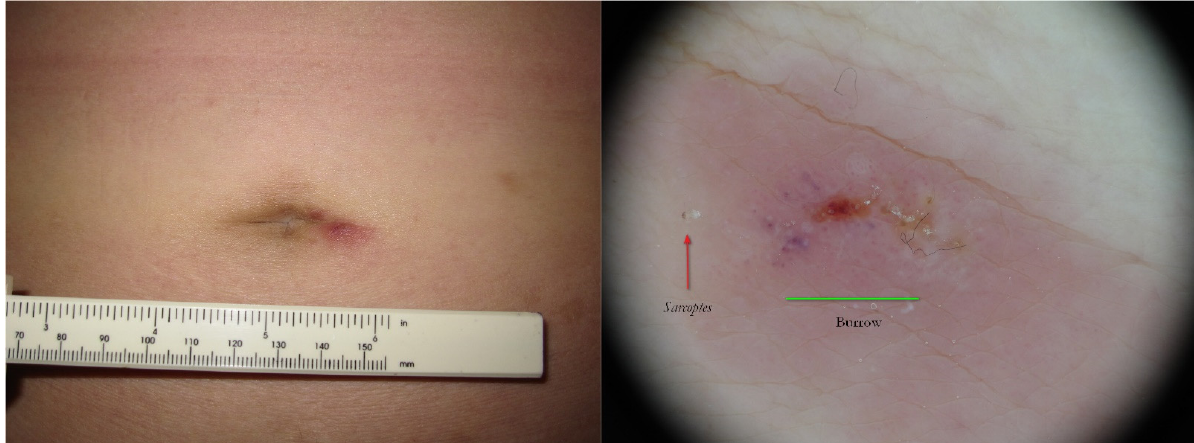
Figure 15. Surrepticius scabies. A non ‐ specific lesion on navel in an asymptomatic patient ( left ). Wet dermoscopy of the same lesion ( right ) showed a Sarcoptes as a brownish triangle (red arrow) and a burrow was no longer distinguishable because it was modified by host phlogosis ‐ exuding reaction (green segment).